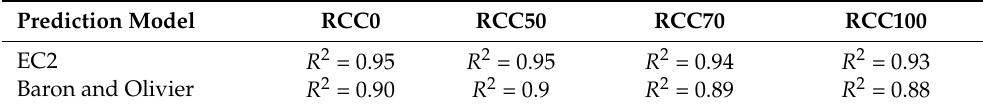
Table 3. Correlation factors between experimental results and prediction models.